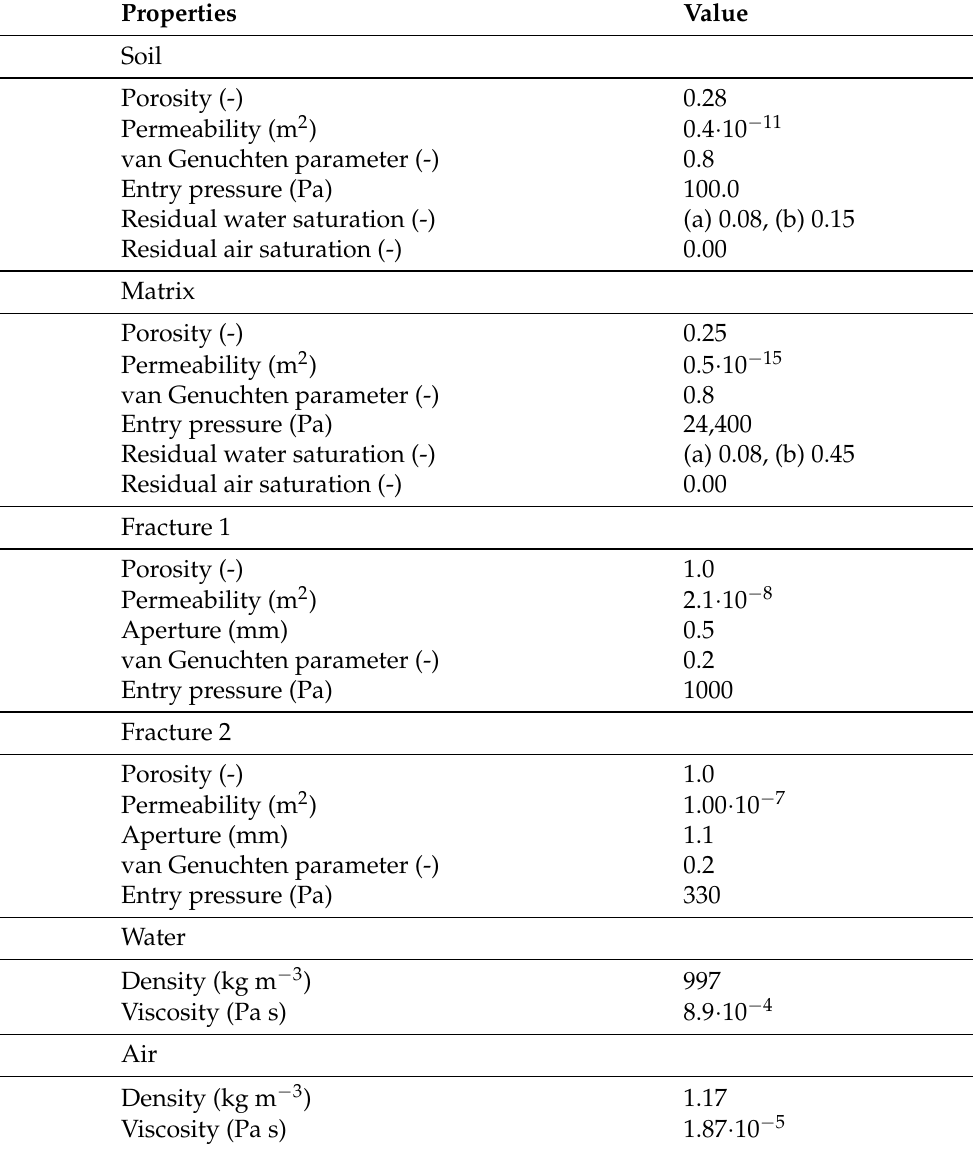
Table 2. Parameterisation and constitutive relationships used in the model TUFF2D. Water properties calculated at 25 ◦ C, and atmospheric